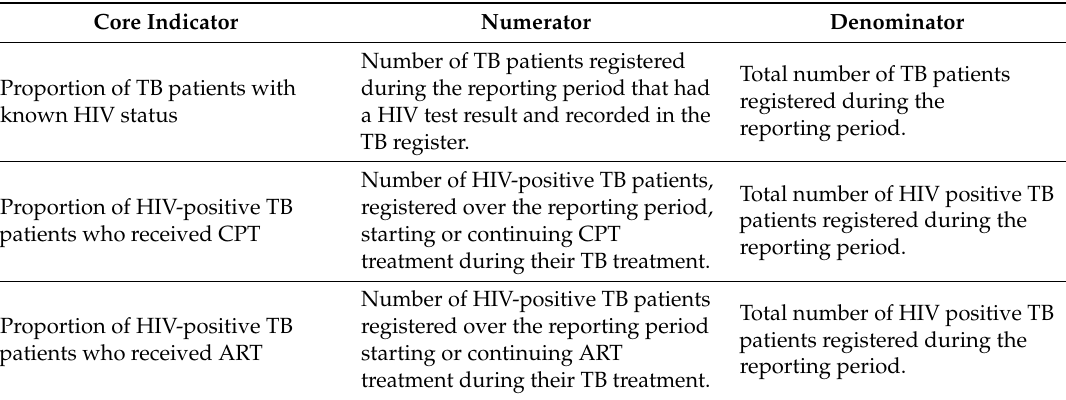
Table 1. WHO recommended core indicators for performance of tuberculosis/human immunodeficiency virus (TB/HIV) services. CPT: cotrimoxazole preventive